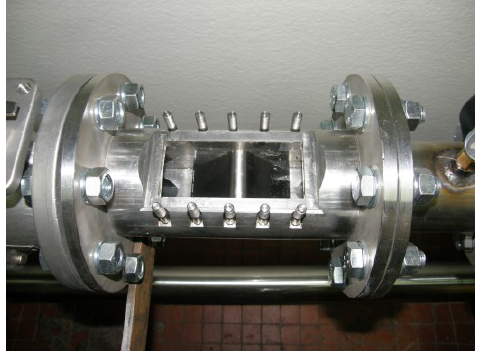
Fig. 1. Cavitation